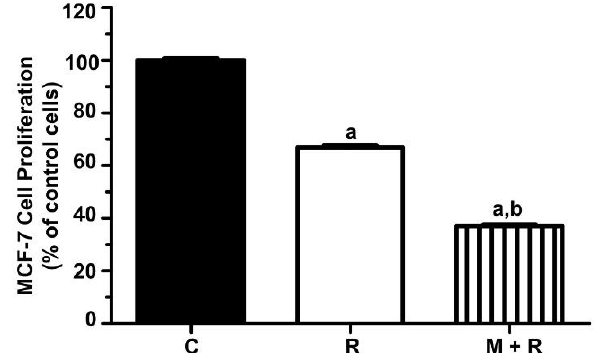
Figure 1. Effect of melatonin pre-treatment and ionizing radiation on MCF-7 cell proliferation. MCF-7 cell proliferation was measured by the MTT method six days after irradiation. Data are expressed as a percentage of control non-radiated cells (mean ± S.E.M.). a, p ≤ 0.001 vs. C; b, p ≤ 0.001 vs. R. C: Control; R: Radiated cells (8 Gy); M + R: Melatonin pre-treated and radiated cells.